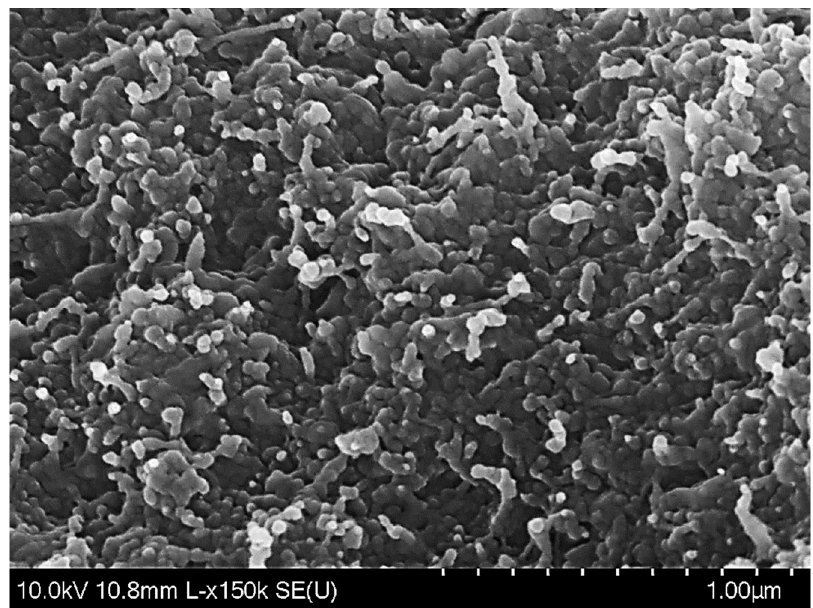
Figure 2. SEM image of freeze-dried nanoparticle co-loaded with tannic acid and